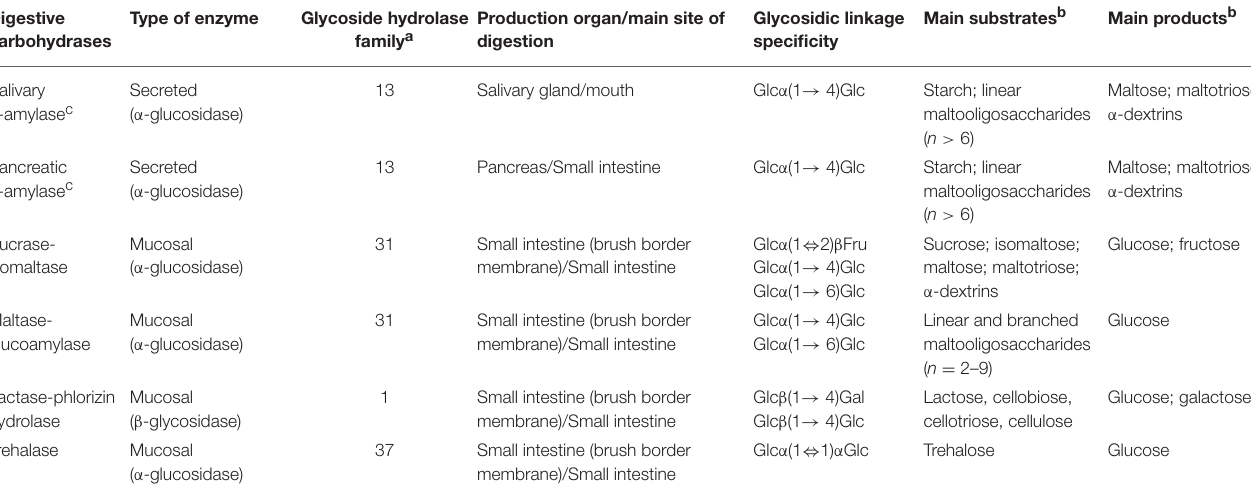
TABLE 1 | Human carbohydrases involved in dietary carbohydrate digestion. Digestive Type of enzyme Glycoside hydrolase carbohydrases